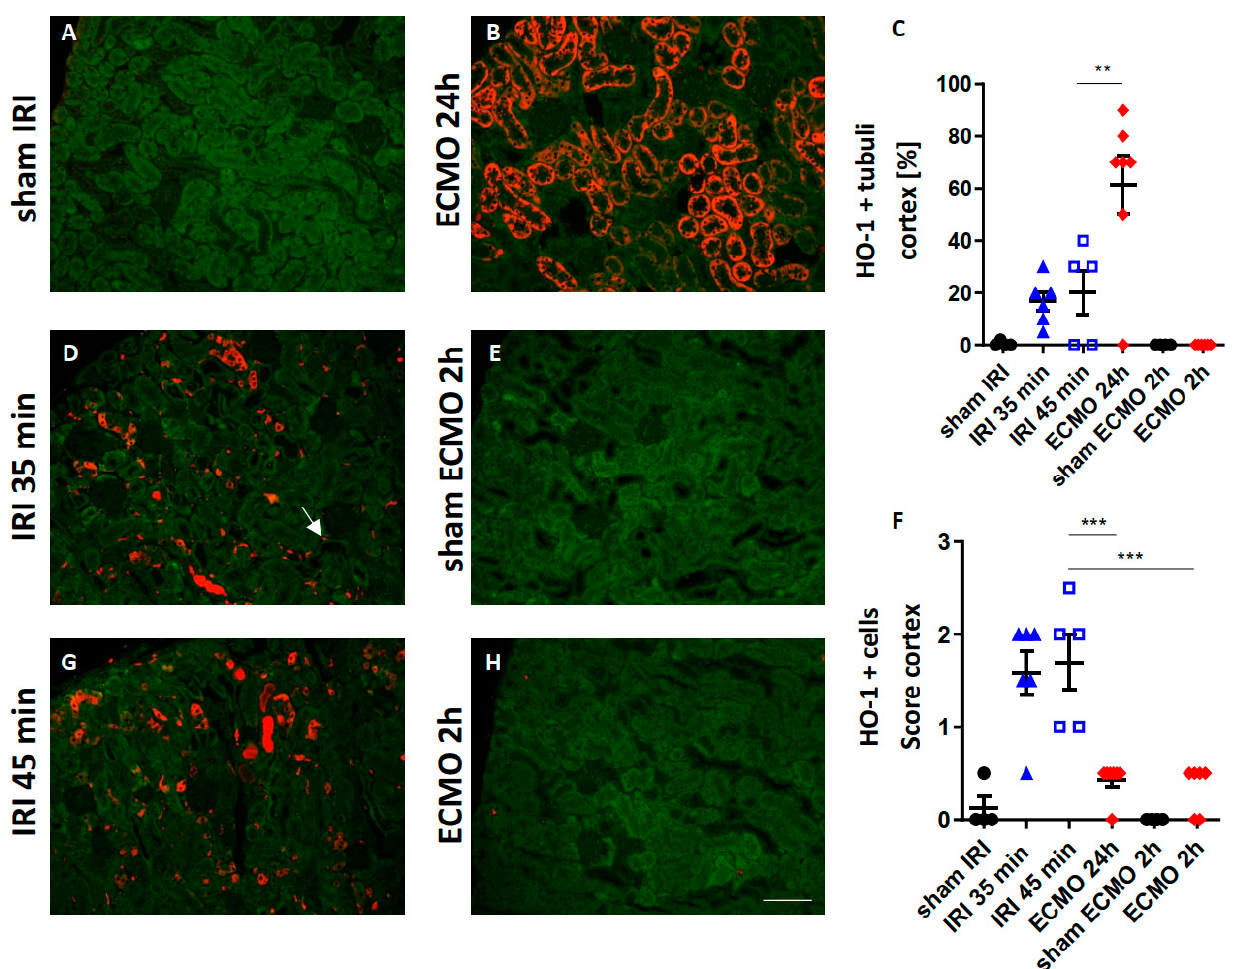
Figure 5. Renal HO-1 expression after moderate and severe renal IRI compared with ECMO. HO-1- stained kidney sections of mice 24 h after moderate ( D ) and severe ( G ) renal IRI and 2 h ( H ) and 24 h ( B ) after ECMO are shown. The HO-1 staining signal is shown in red, tubular autofluorescence in green. Sham-IRI mice and sham-ECMO mice served as controls ( A , E ). Two hours after ECMO no renal HO-1 expression was evident ( E ). However, 24 h after ECMO strong tubular upregulation of HO-1 was observed ( B , C ). Moderate and severe renal IRI only caused minor tubular HO-1 expression ( D , G , C ). However, after renal IRI the extent of HO-1 expressing cells (white arrow) was significantly higher in the renal cortex compared with ECMO ( F ). ** p < 0.01, *** p < 0.001. Scale bar 100 µ